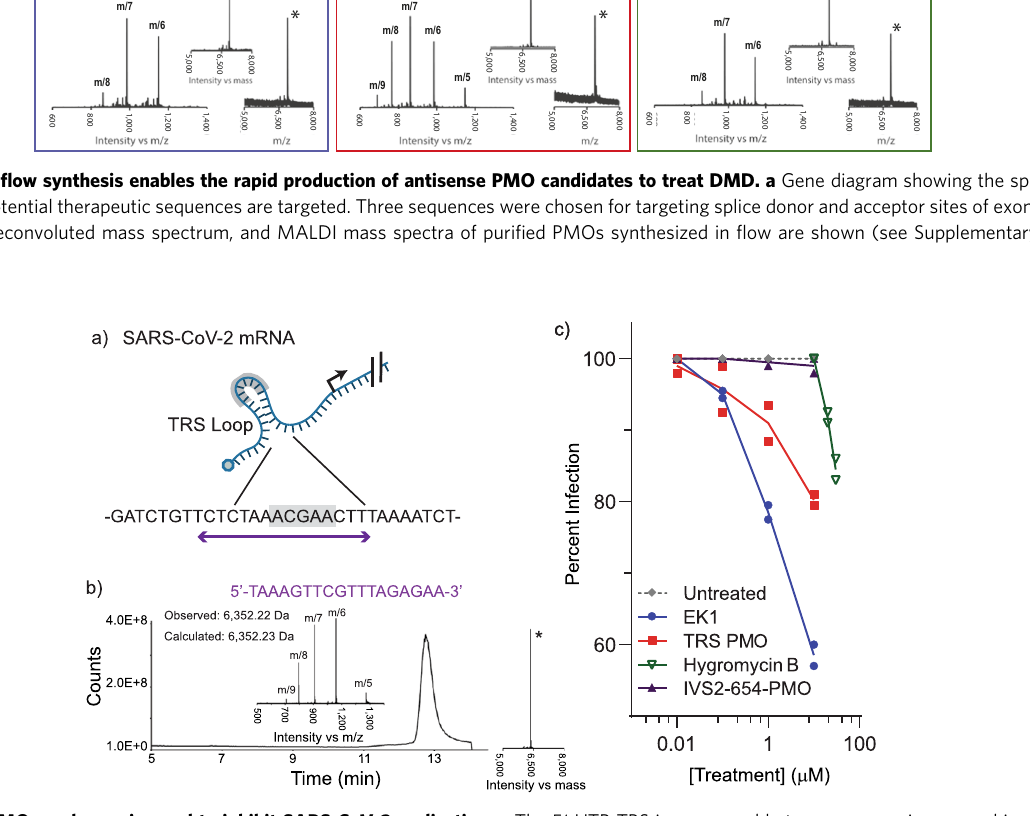
Fig. 6 Synthetic PMO can be engineered to inhibit SARS-CoV-2 replication. a The 5 ′ UTR TRS is conserved between coronaviruses, and is a target for antisense knockdown of viral replication. The TRS is shown in gray, and a sequence was chosen to encompass this region and surrounding bases, an effective strategy for targeting the SARS-CoV-1 mRNA. b The TICC, mass spectrum, and deconvoluted mass spectrum of the puri fi ed PMO sequence are shown. c Inhibition of native SARS-COV-2 by various treatments is shown. Percent inhibition represents observed viral reductions in culture supernatants as measured by qRT-PCR, as compared to untreated control. Increasing concentrations of TRS-PMO results in inhibition of viral replication. Inhibition of viral growth is observed, as previously reported for EK1 and hygromycin B. Measurement at each concentration is from n = 2 biological replicates, with each point averaging two technical replicates.